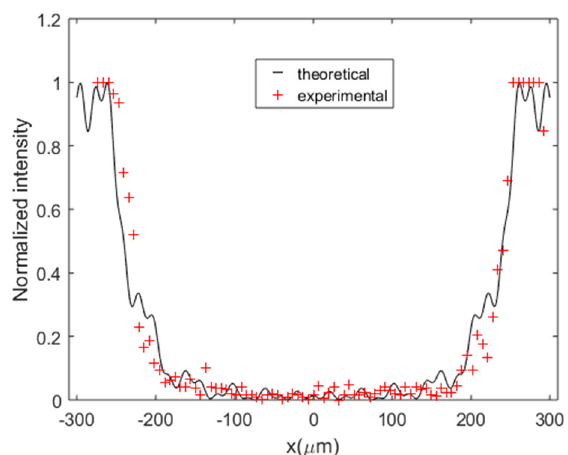
Figure 16. Experimental data and theoretical fit of the intensity recorded on a CCD camera from the diffraction of a crack in a piece of plastic.